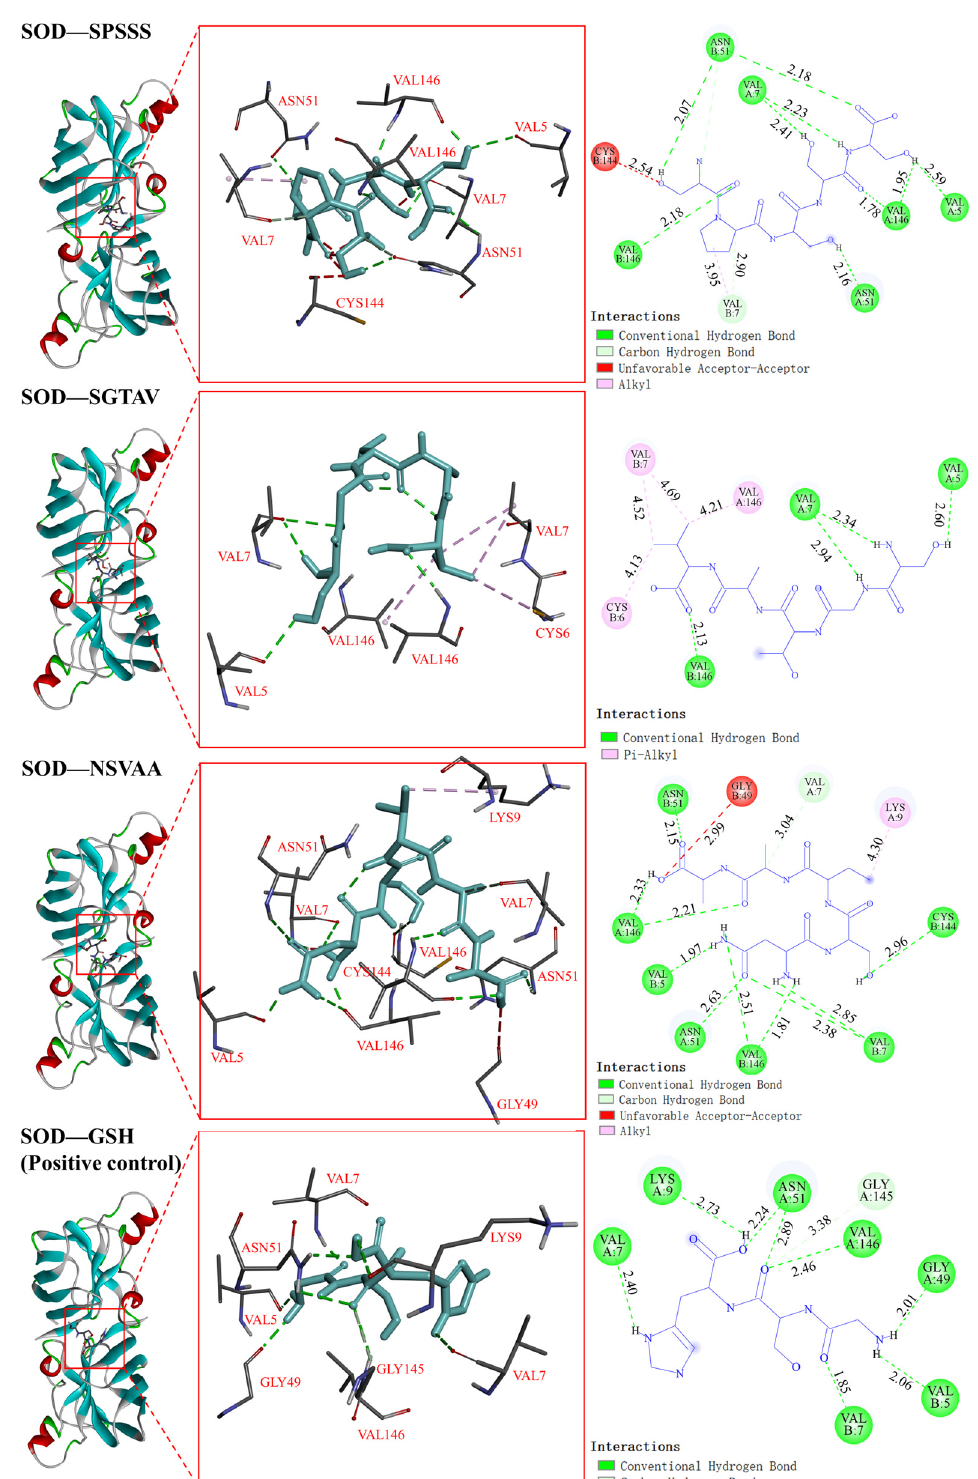
Figure 8. Visualization of molecular docking of antioxidant peptides SPSSS, SGTAV, and NSVAA and positive control (GSH) with SOD.